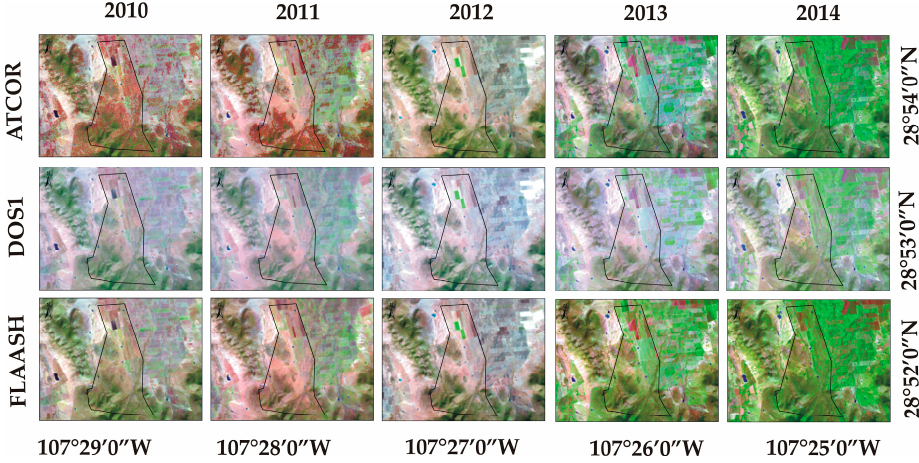
Figure 4. False-color images from the different radiometric correction algorithms. Site: El Sitio.